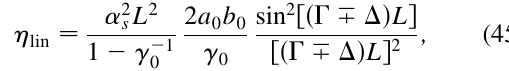
FIG. 16. The parameters f correspond to the value (cid:9) ¼ 0 (solid lines), as functions of electron energy (cid:3) for different amplitudes of the wiggler field (cid:4)